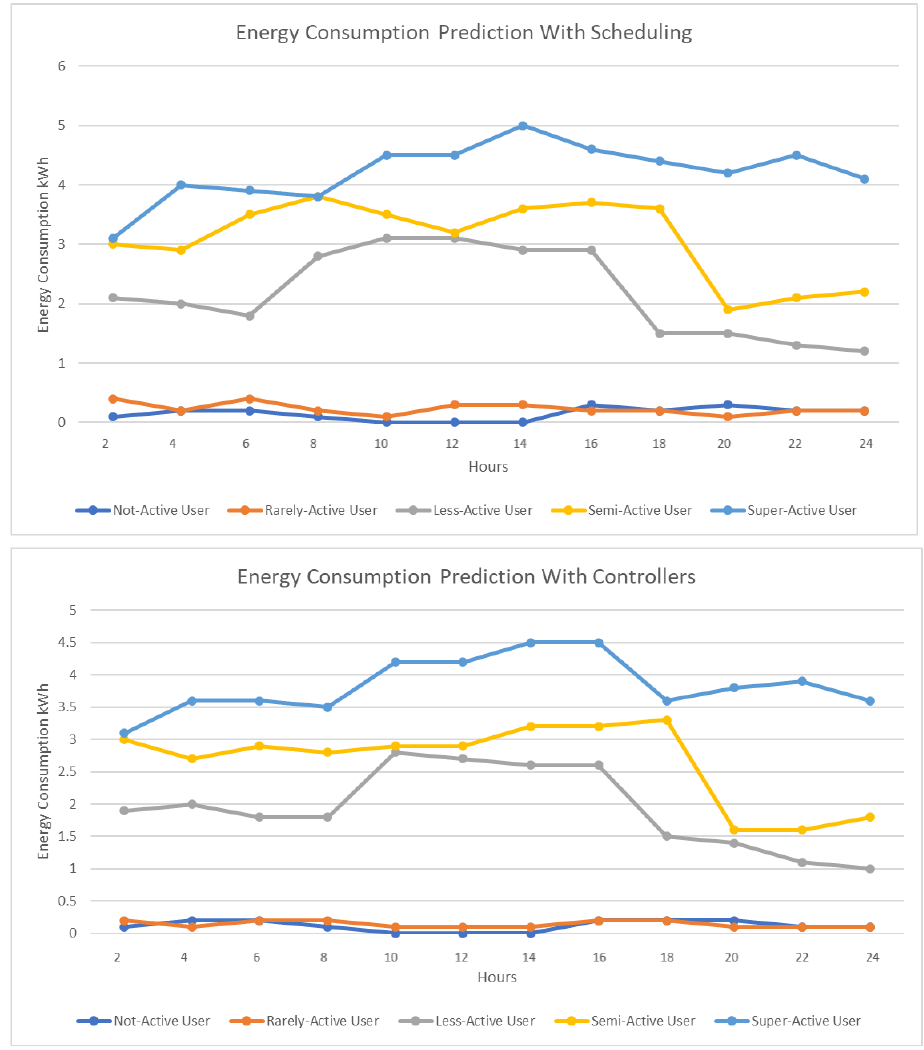
Figure 10. Energy consumption with controllers.